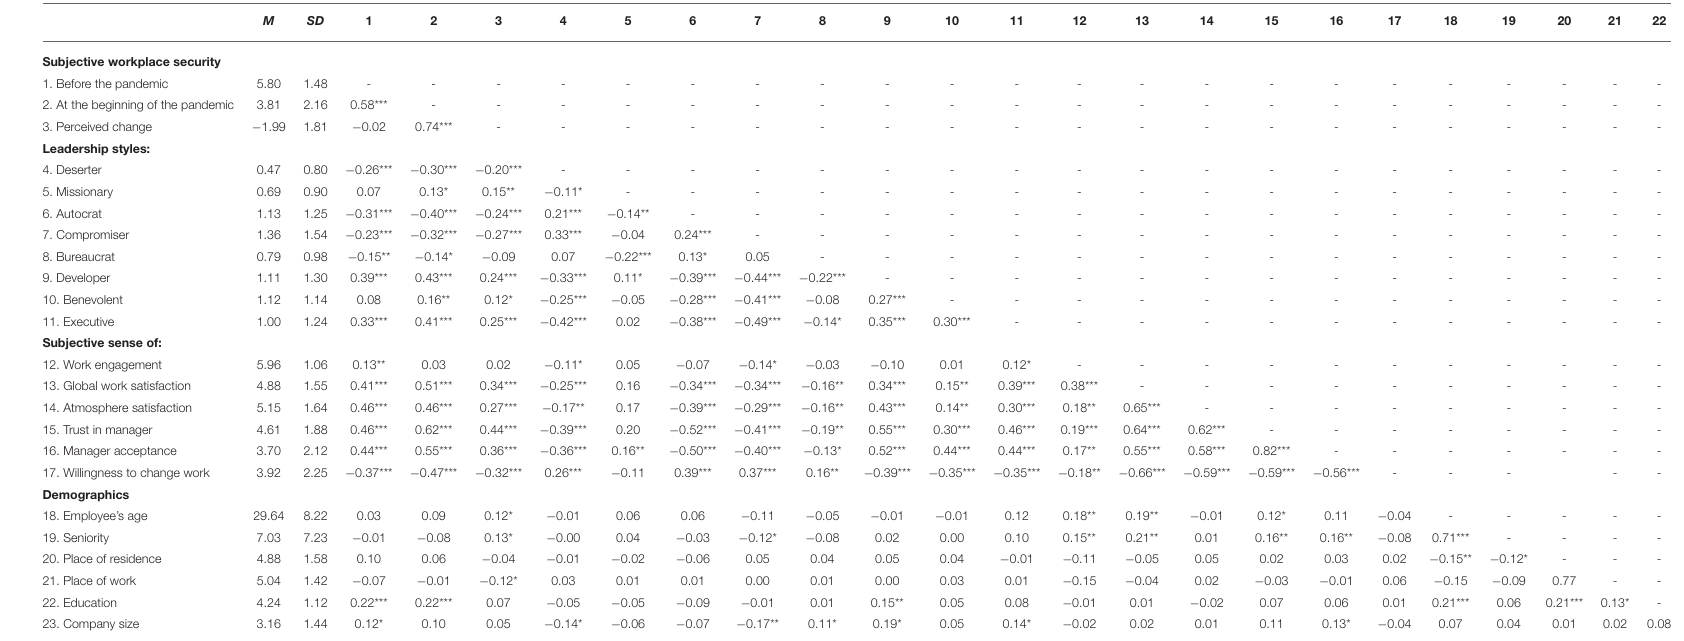
TABLE 2 | Descriptive statistics and correlations between variables measured in the